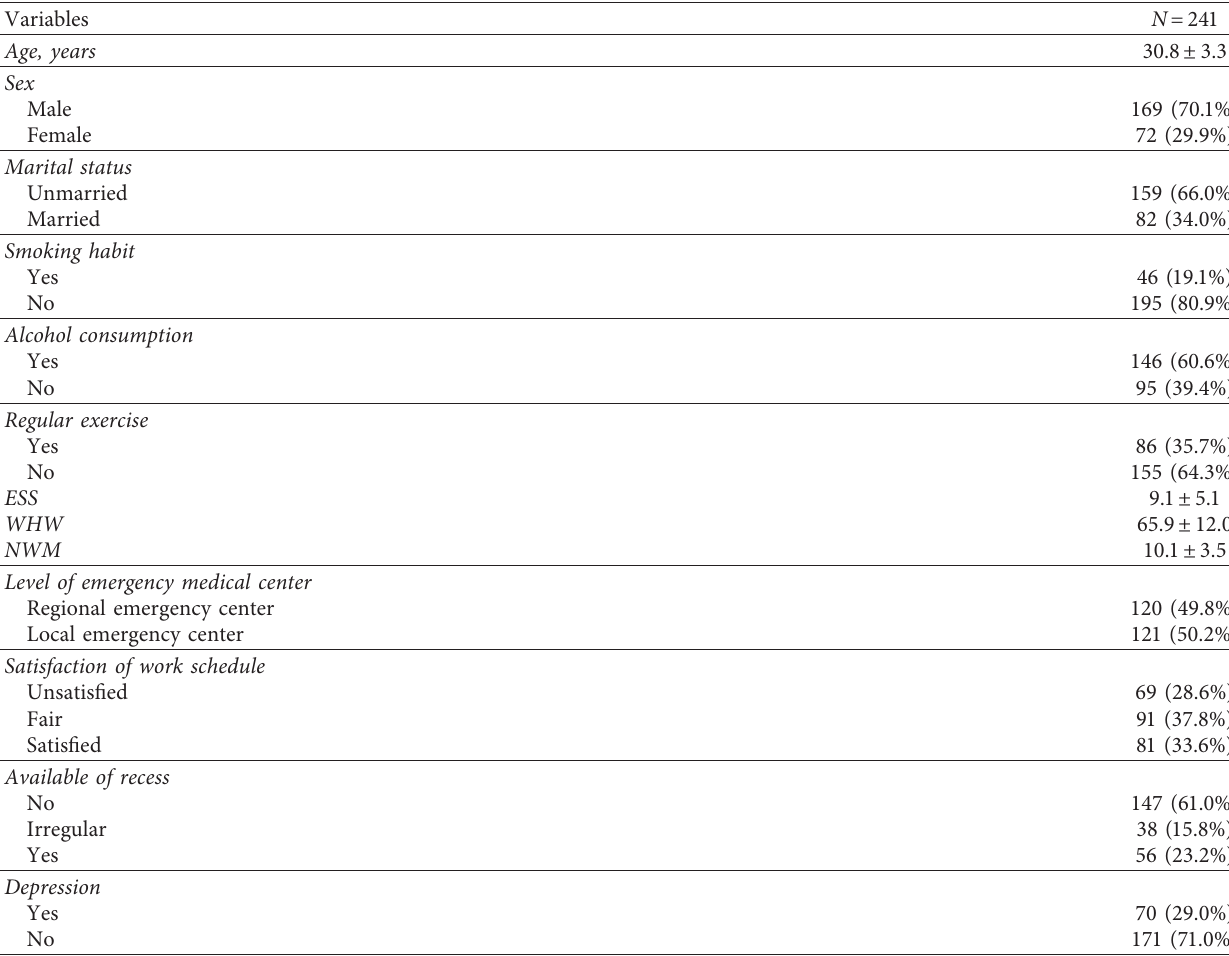
Table 1: Baseline demographic characteristics and work environment of the EM residents.